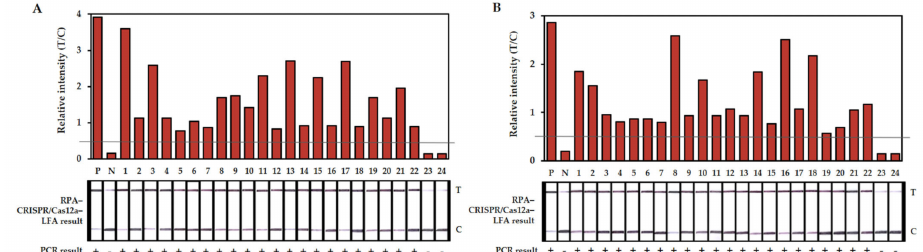
Figure 5. Scab diagnosis of field leaf samples ( A ) and fruit samples ( B ) using RPA-CRISPR/Cas12a- LFA and PCR. The relative quantifications of band intensities are shown at the top and LFA strip results are shown at the middle and PCR results are shown at the bottom. The gray horizontal line indicates the relative intensity threshold for positive result. N: negative control, no template, P: positive control with 1 ng of the total gDNA of E. fawcettii , T: test line, C: control line. Table 2. Test of the specificity of the RPA-CRISPR/Cas12a-LFA system compared with that of conventional PCR analysis with field samples. Leaves Fruits